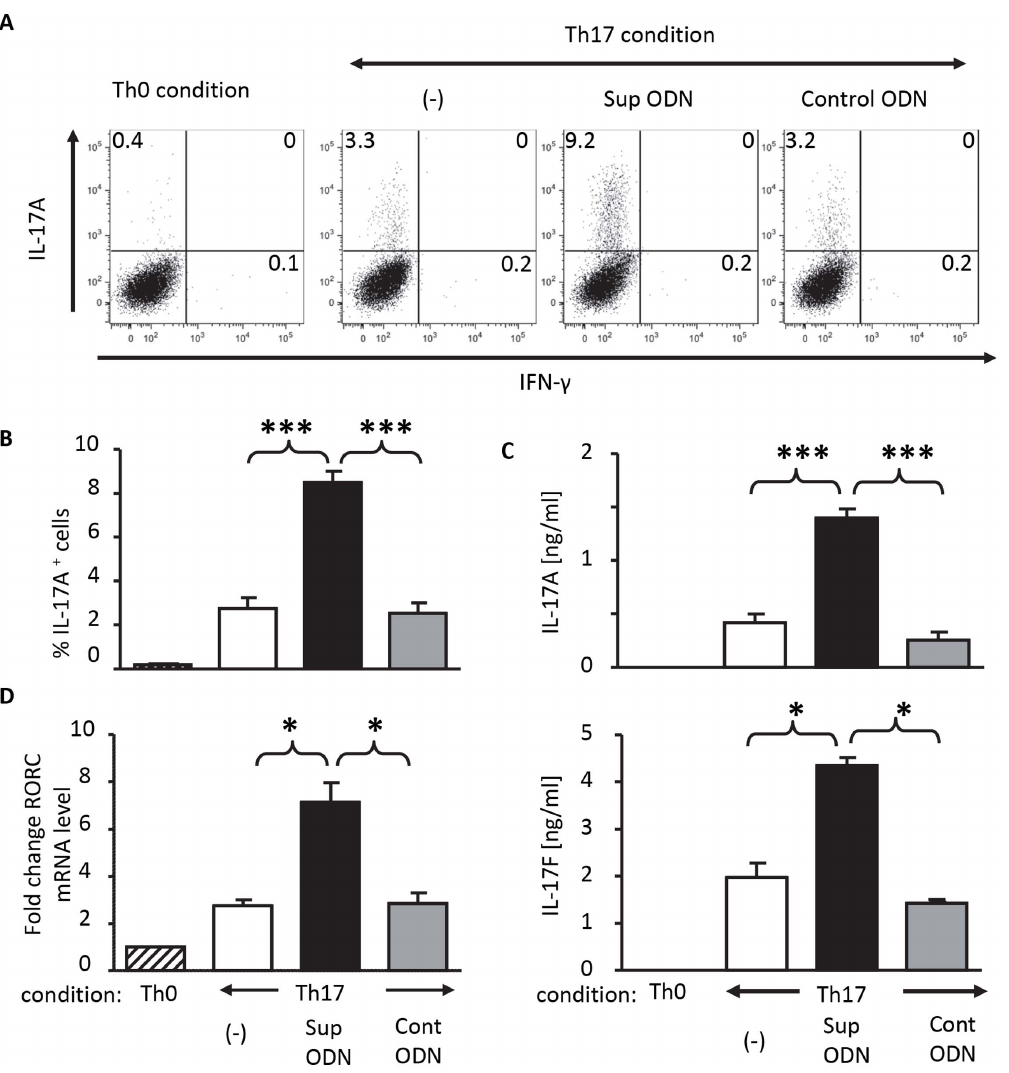
Figure 1. Suppressive ODN promote the maturation of Th17 cells. Highly purified naive CD4 + T cells from female C57BL/6 mice were incubated for 2 h with 1 m M of suppressive or control ODN and then cultured for 3 days under Th0 or Th17 polarizing conditions (see methods section for details). (A) Frequency of cells producing IL-17A and IFN c in samples as determined by intracellular staining and flow cytometry. (B) Combined results (from 4 independent experiments) showing the mean + SD of the effects of treatment on the frequency of IL-17A + cells. (C) Level of IL17A and IL-17F protein in culture supernatants of cells stimulated under Th17 polarizing conditions for 3 days (mean + SD of 4 experiments). (D) Level of mRNA encoding RORC determined by RT-PCR. mRNA levels in cells treated under Th17 polarizing conditions are compared to those generated under Th0 conditions after normalization to GAPDH mRNA for each sample. Each bar represent the mean + SD of 3 independent experiments. *, p , 0.05; ***, p ,